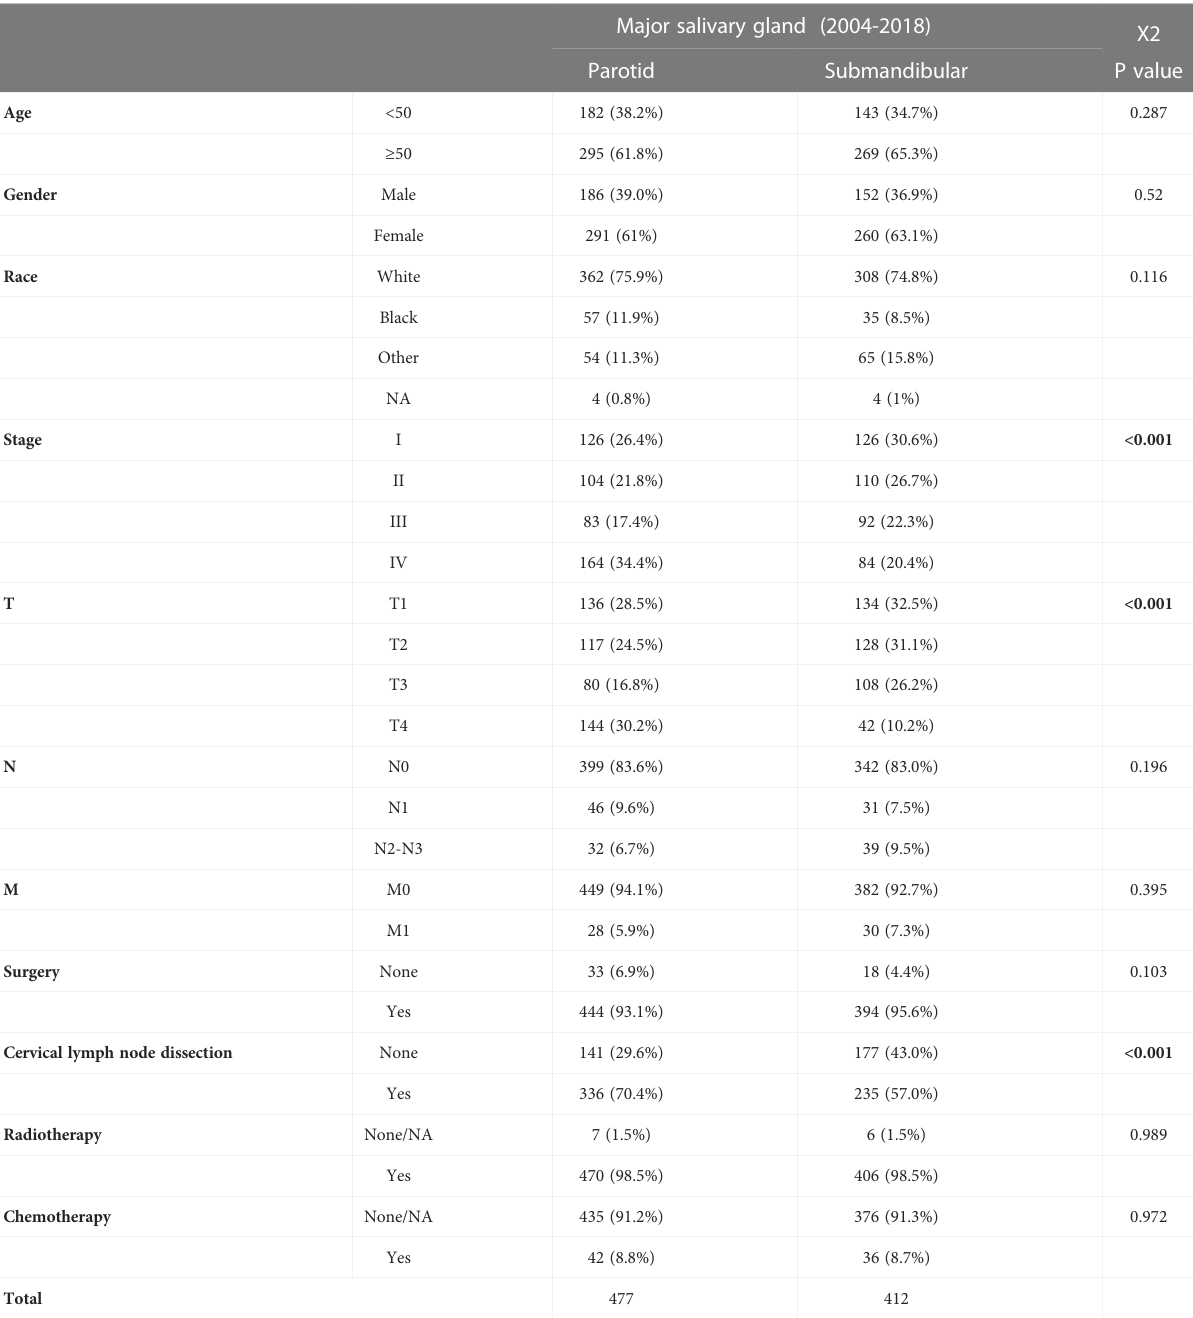
TABLE 1 Differences in the clinical characteristics of patients with submandibular and parotid glands ACC from the SEER